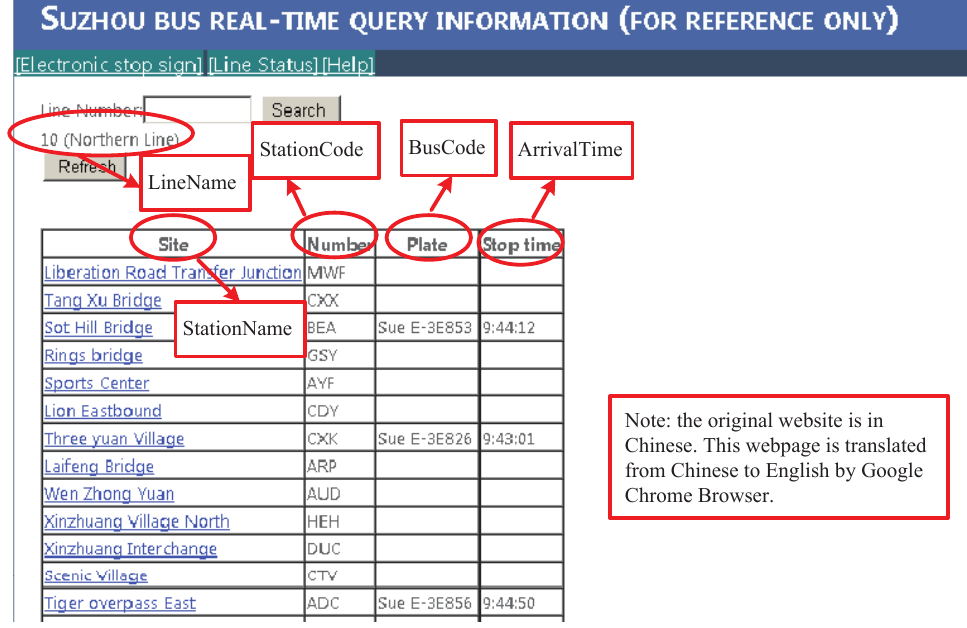
Figure 1. Snapshot of the web page for the bus arrival information on the official website in